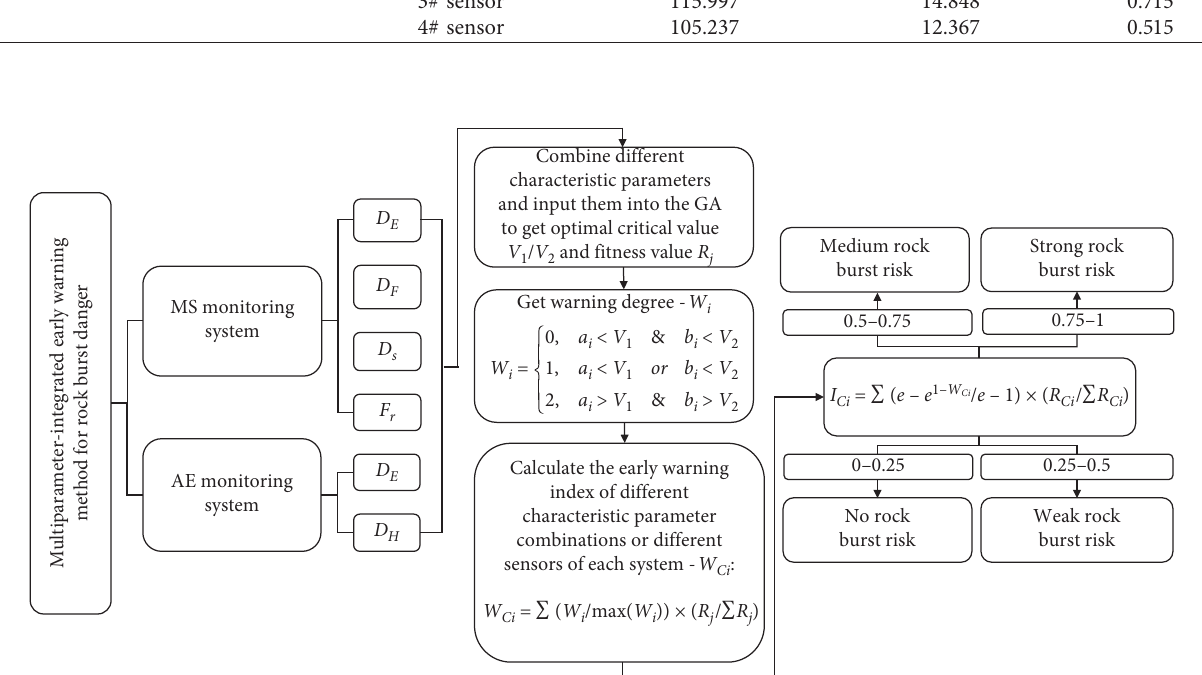
Figure 10: The flowchart of multisystem and multiparameter integrated early warning method of rock burst risk in